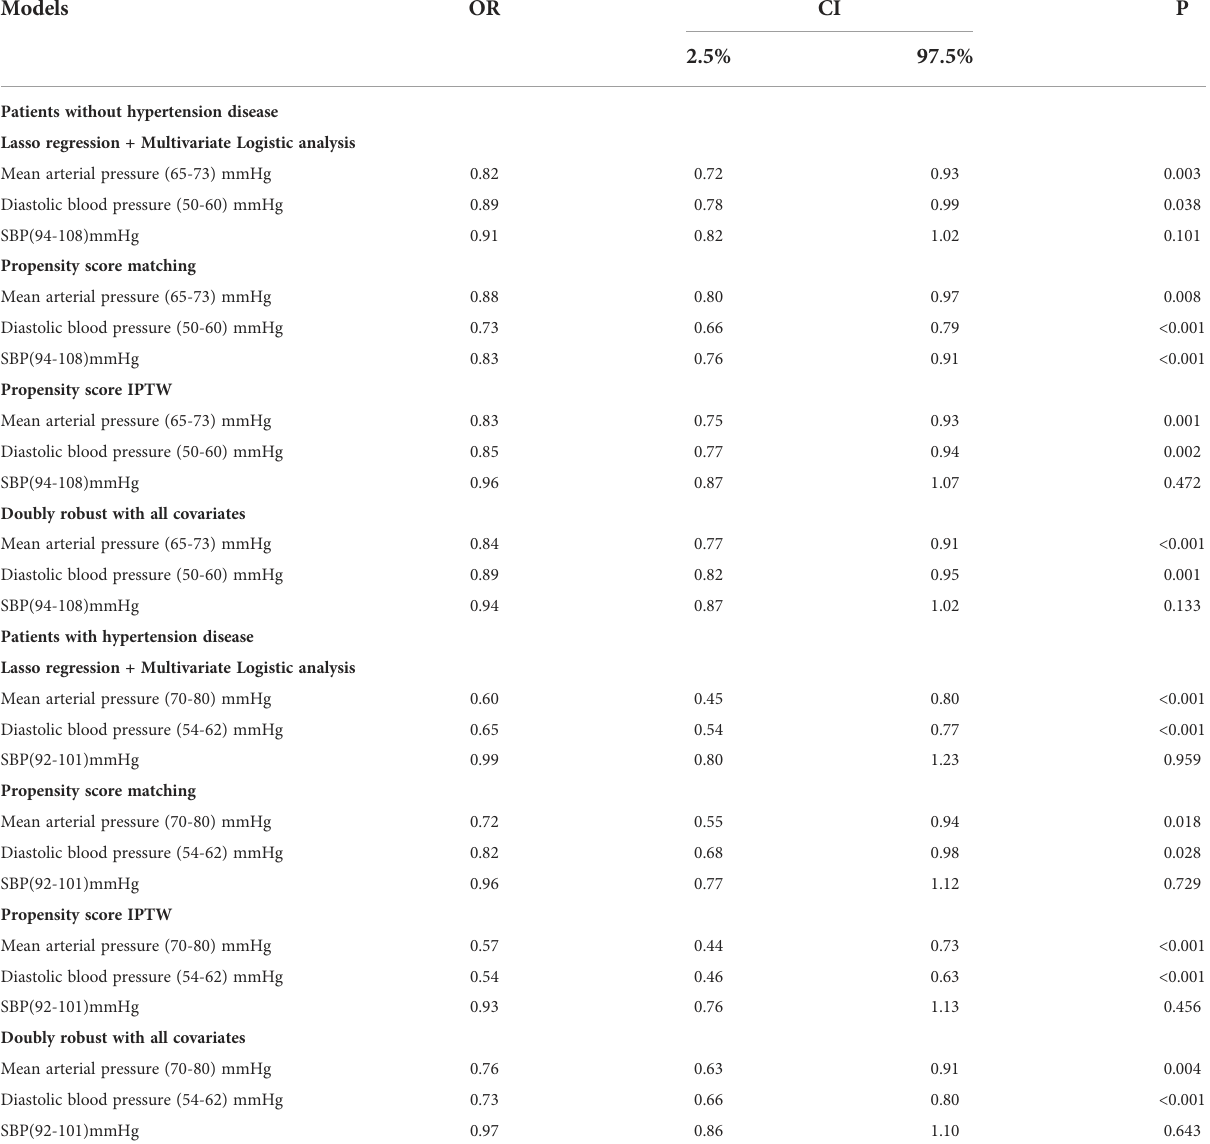
TABLE 2 Application of multiple models to explore blood pressure indicators to predict the occurrence of sepsis with AKI. Models